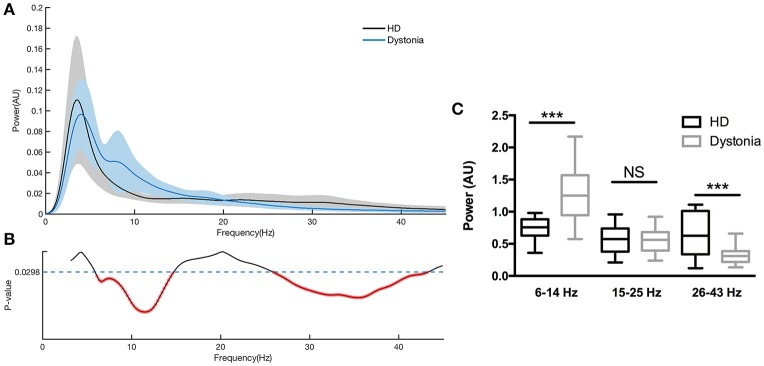
Power spectra over 3–45 Hz across subjects with dystonia or HD. Groups were compared by two-sample, unpaired t-tests. LFPs were z-transformed before spectral analysis. Spectral resolution is 0.5 Hz. (A) The blue line and shadows represents the average (± standard error) power of the dystonia group and the gray line represent the average (± standard error) power of the HD group. (B) Statistical comparisons of band powers between dystonia and HD groups. Significant differences were found for 6–14 and 25–43 Hz bands. (C) The mean total power values at 6–14, 15–25, and 26–43 Hz for each group are shown in the histogram. Significant group differences were found for the 6–14 and 26–43 Hz bands (p < 0.0298, corrected p-value). No significant group difference was found for the 15–25 Hz band. ***p < 0.05.